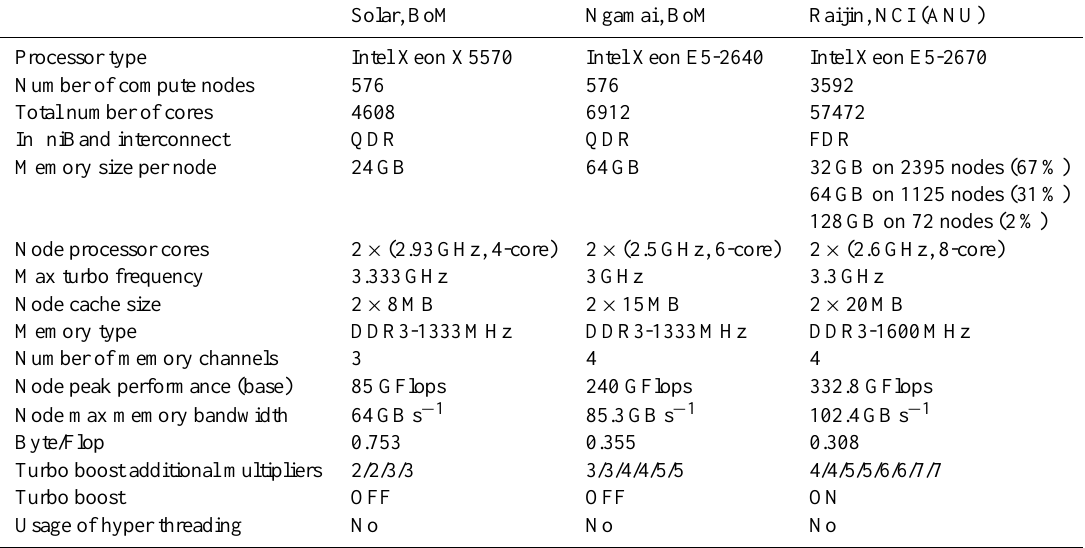
Table 1. Intel Xeon Compute System